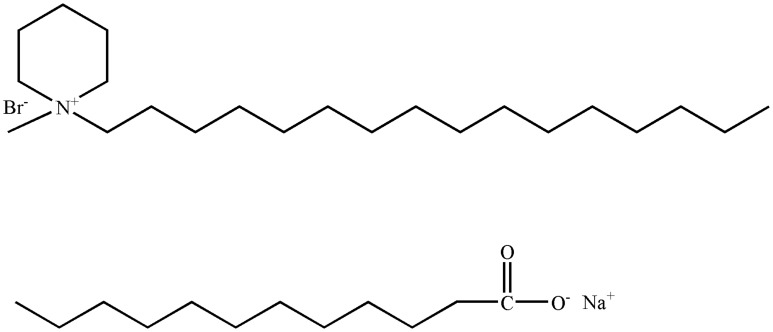
Chemical structure of C16MDB (a) and Sodium Laurate (b).